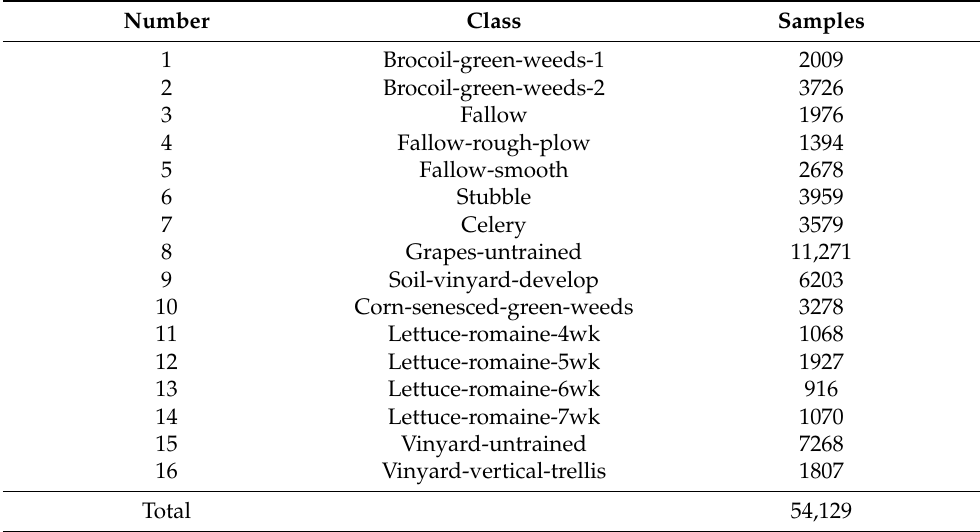
Table 2. Ground truth classes and their individual samples number for Salinas.